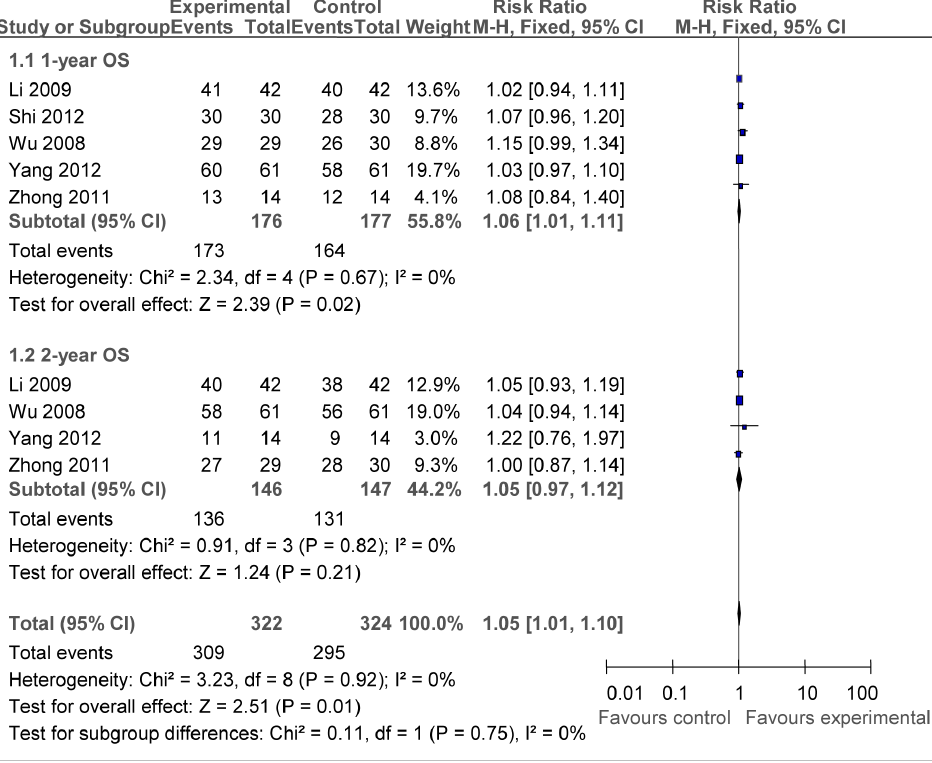
Figure 2. Forest plot of the comparison of overall survival (OS). P values are from P for the effect modification evaluation of heterogeneity within or across the groups of regimens. CI, confidence interval; RR, risk ratio; DC/CIK, DC-CIK immunotherapy; Chemo, chemotherapy; Con, control group; Exp, experimental group. A fixed-effect meta-analysis model (Mantel-Haenszel method) was used.